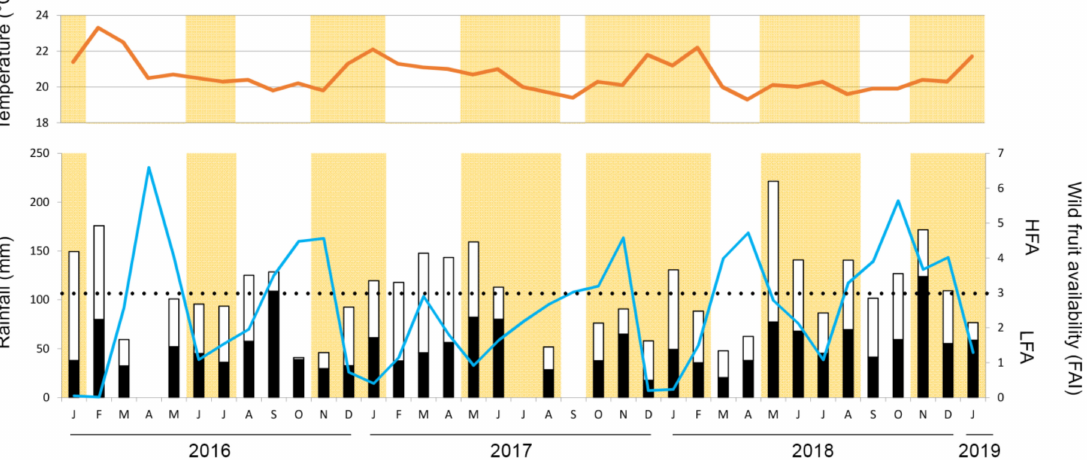
Figure 2. Maize calendar, wild fruit availability, rainfall, and mean temperature between January 2016 and January 2019. The red line represents the mean monthly temperature, and the blue line is the total monthly rainfall (mm). Months with a yellow background correspond to months with edible maize at the PNK edges. Black and white bars represent the monthly wild ripe and unripe fruit availability (FAI), respectively. FAI data were missing for April 2016, as well as July and September 2017. Dotted line represents the limit between low (LFA) and high wild fruit availability